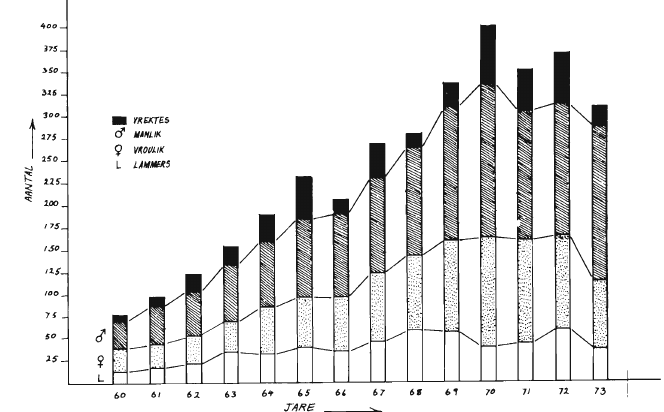
Fig. 2. Lewenshistogram van die bontebok in die Bontebok Nasionale Park 1960-1973. 9:d' L~M %